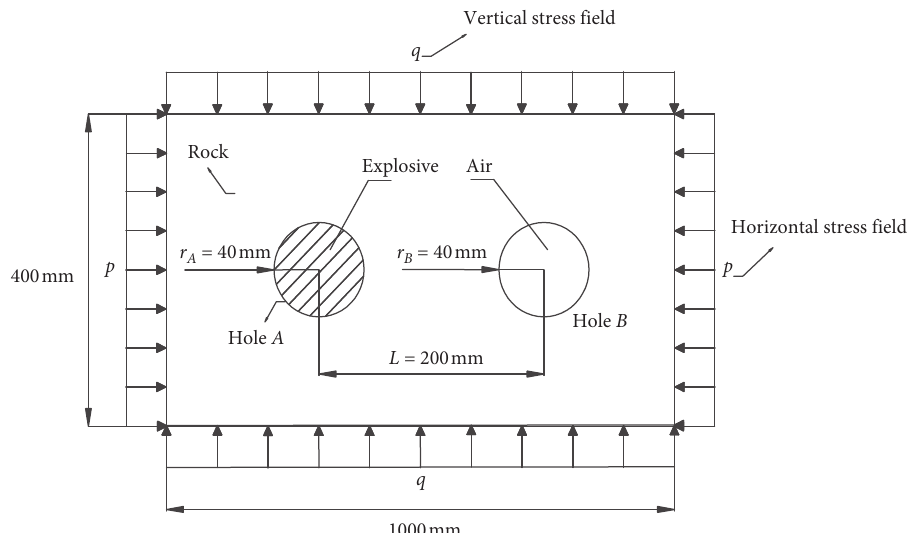
Figure 1: Schematic of the numerical simulation